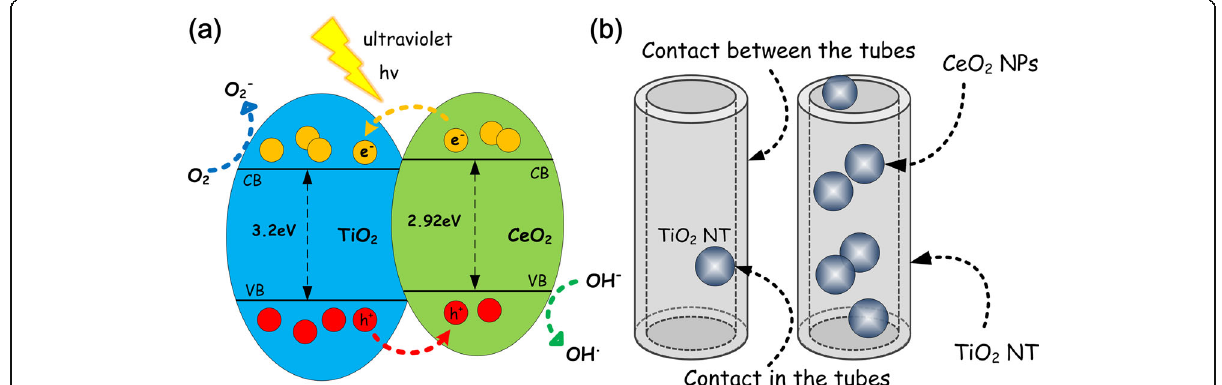
Fig. 1 a Energy levels of TiO 2 NTs and CeO 2 NPs with electron-hole pair transfer and separation. b Illustration diagram of CeO 2 NP and TiO 2 NT